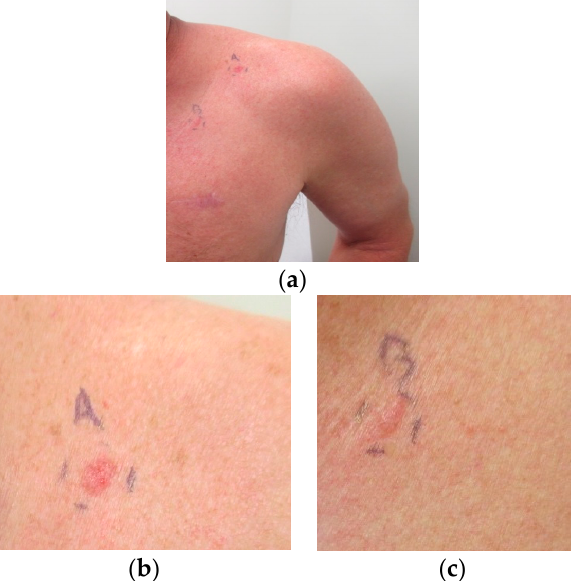
Abbreviations: bold , possible germ cell mutation.